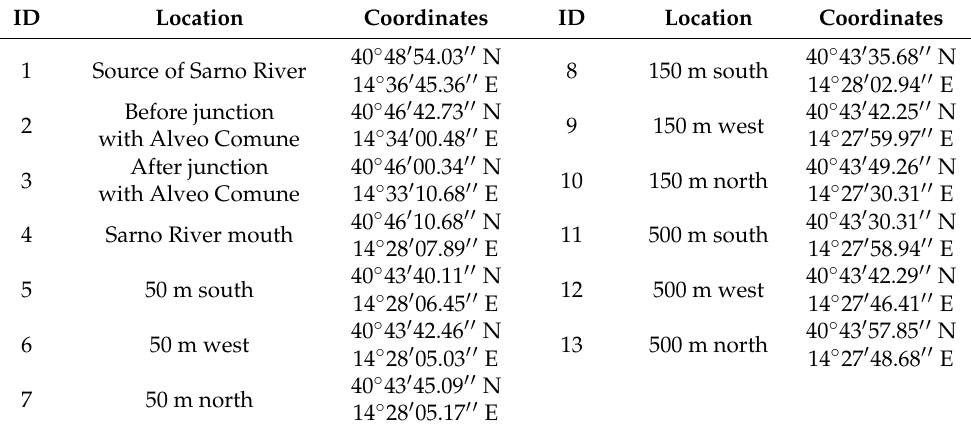
Figure 3. Hydrographic network and sampling sites near the Sarno River. Table 2. Sampling sites with their identification number (ID), location name, and coordinates from the Sarno River.